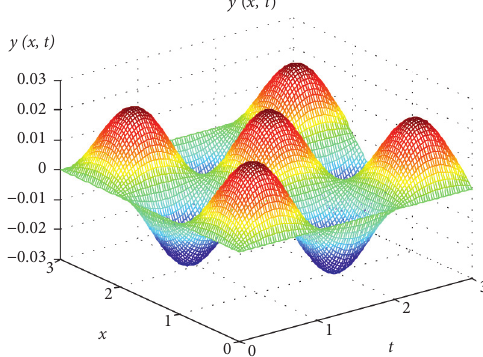
Figure 6: The change surface of first 3 orders of vibration response superposition y ( x , t ) with time t (s) of the hydraulic pipe.